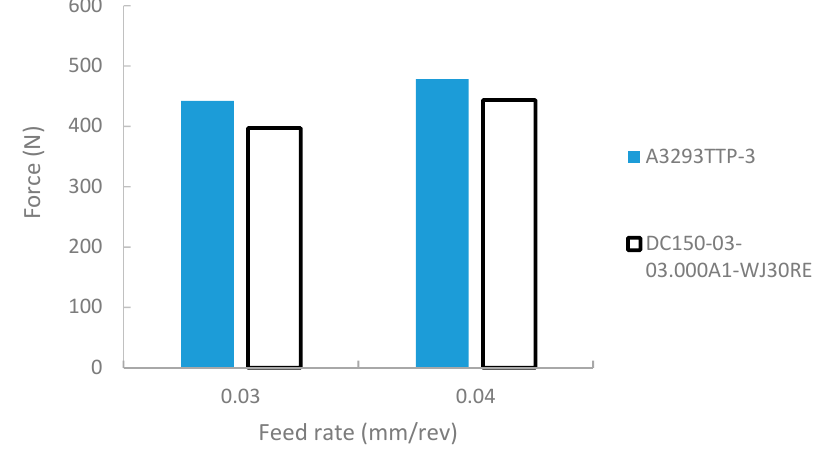
Figure 10. E ff ect of cutting tool coating grade on cutting Figure 10. Effect of cutting tool coating grade on cutting force.